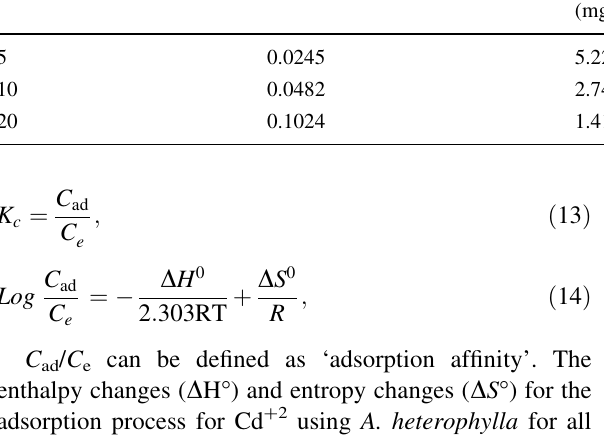
Fig. 3 First-order kinetics of Cd ? 2 on A. heterophylla at 30 (cid:3) C, CT 30.039 mg L - 1 and pH 4.5 ( a ), second-order kinetics at 30 (cid:3) C, CT 30.039 mg L - 1 and pH 4.5 ( b ), Vant Hoff plot at biomass weight 20 g L - 1 and pH 5.5 ( c ) and desorption cycle of Cd(II) ( d Table 3 Kinetic parameters for cadmium(II) biosorption on A. heterophylla W (g L - 1 )